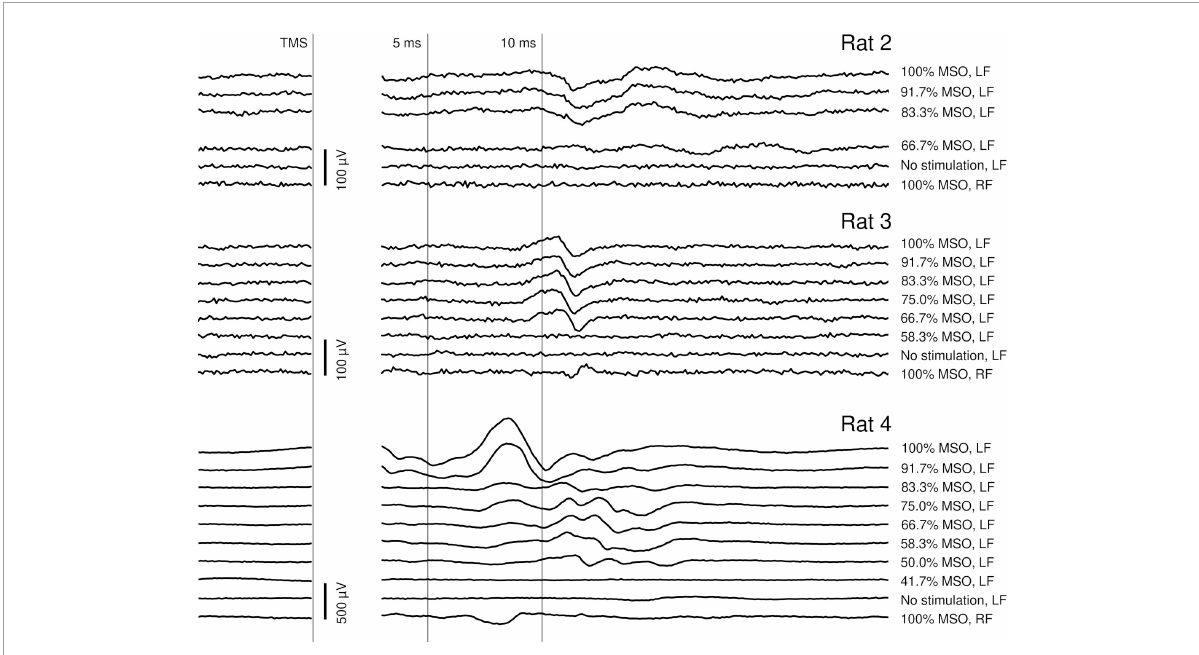
FIGURE3 Dependency of the individual EMG responses on the transcranial magnetic stimulation (TMS) intensity at a fixed stimulation location in rats 2–4. MSO, maximum stimulator output; LF, left forelimb; RF, right forelimb. The bottom trace of every chart (100% MSO intensity, RF response) was recorded simultaneously to the top trace (100% MSO intensity, LF response), which allows assessing the lateralization of the response. In all three rats, stimulation below a specific intensity caused no responses. In rat 4, the response consisted of few components with different thresholds; a high-amplitude, high-threshold component had an onset latency of about 7 ms. This component was probably caused by a direct TMS action on subcortical or cervical motor structures. The component with a longer onset latency (9–10 ms) recorded in all rats was potentially caused by the activation of the cortex. The stimulation artifact has been masked.